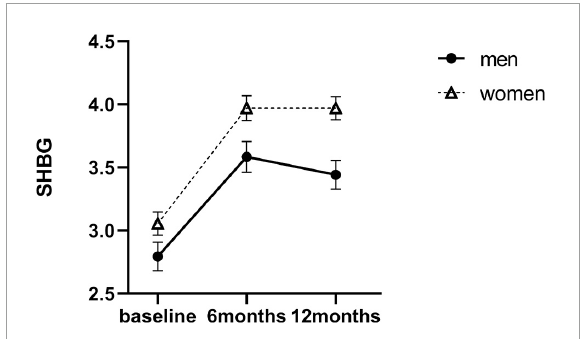
FIGURE3 Estimated marginal means (y-axis) of SHBG for men and women group over time points (x-axis). Error bars indicate standard error. SHBG, sex hormone–binding globulin.